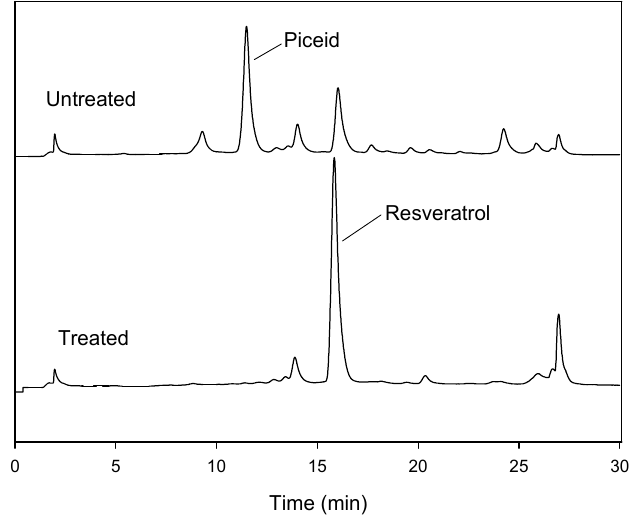
Figure 3. HPLC chromatogram of the extracts of P. cuspidatum root untreated and treated with cellulose.